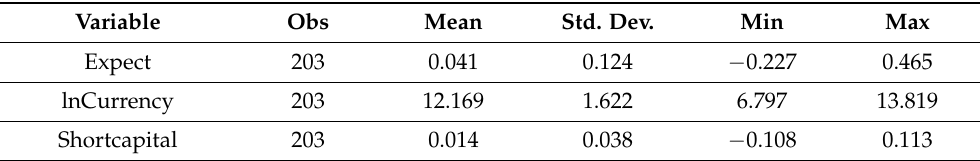
Table 3. Statistical